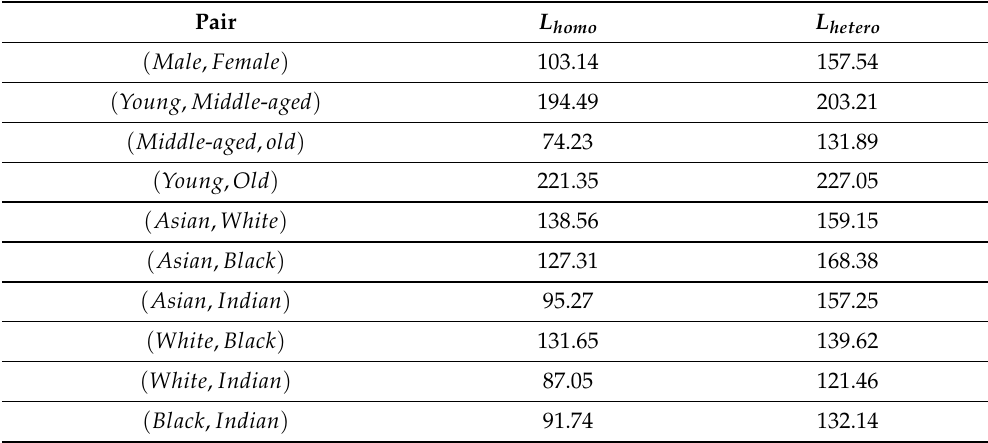
Table 1. Comparison of differences of faces that belonged to different groups in sex.